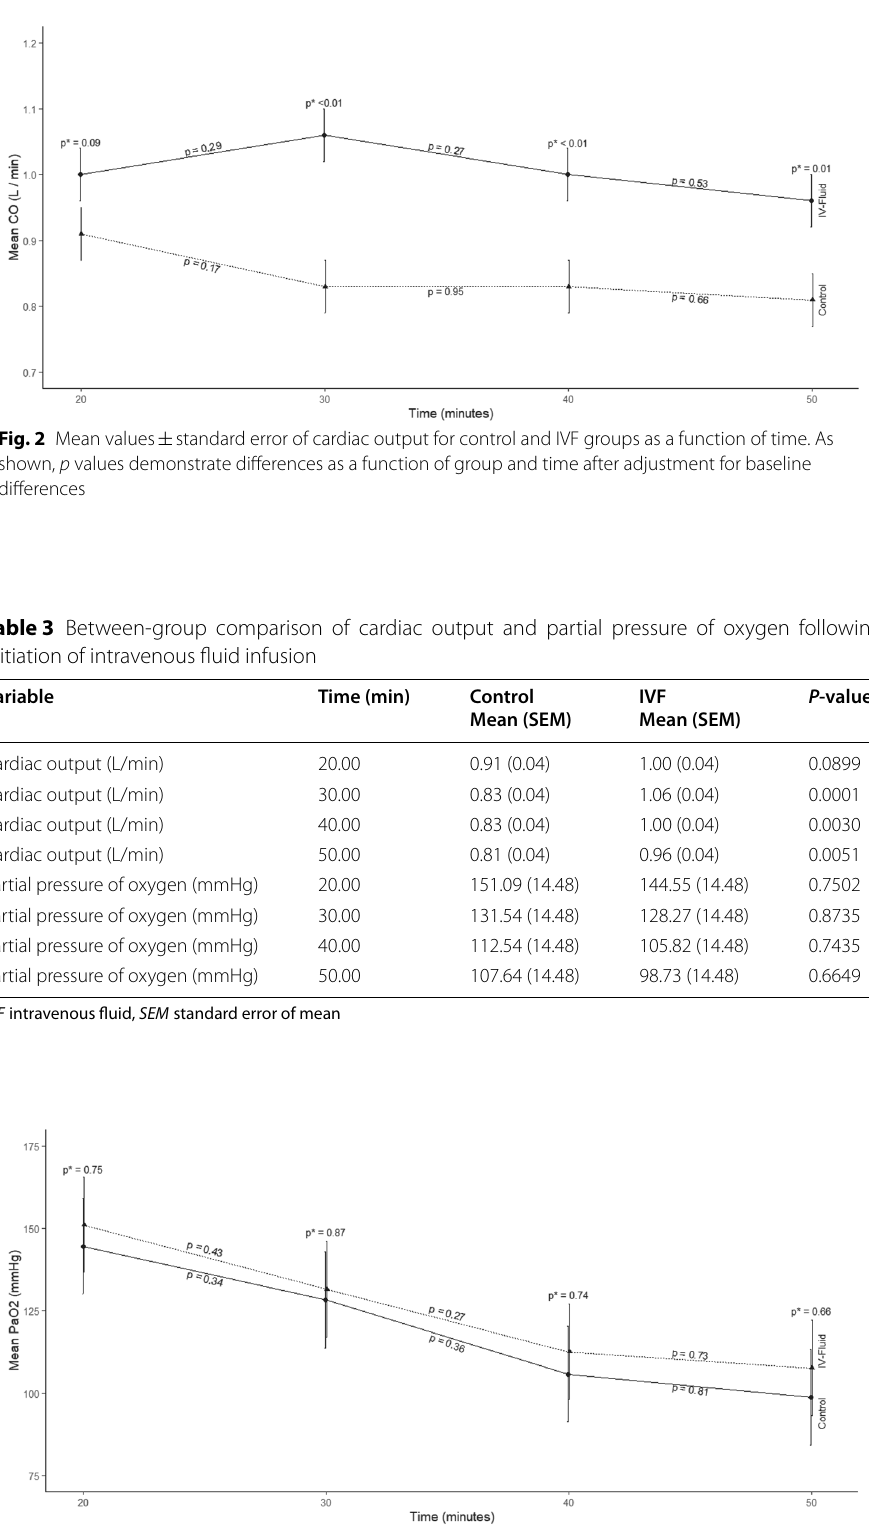
Fig. 3 Mean values standard error of partial pressure of oxygen for control and IVF groups as a function ± of time. As shown, p values demonstrate differences as a function of group and time after adjustment for baseline